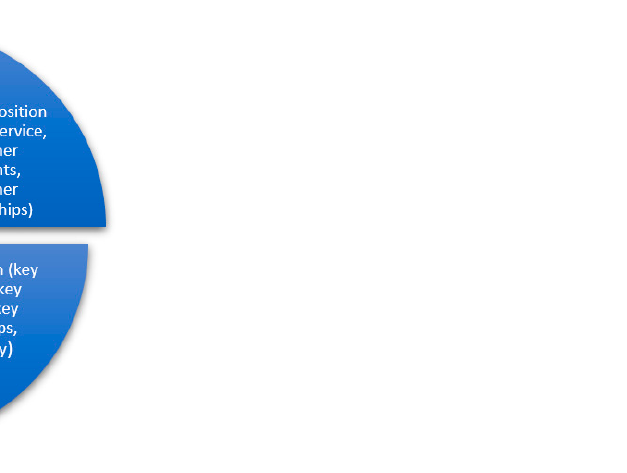
Figure 1. Business model components. Prepared on the basis of [5] (p. 24), [6] (p. 402), [7] (p. 43), [8] (pp. 16–19), [9] (p. 9, 12). The figure was created using the program Microsoft ® Word for Microsoft 365 MSO.